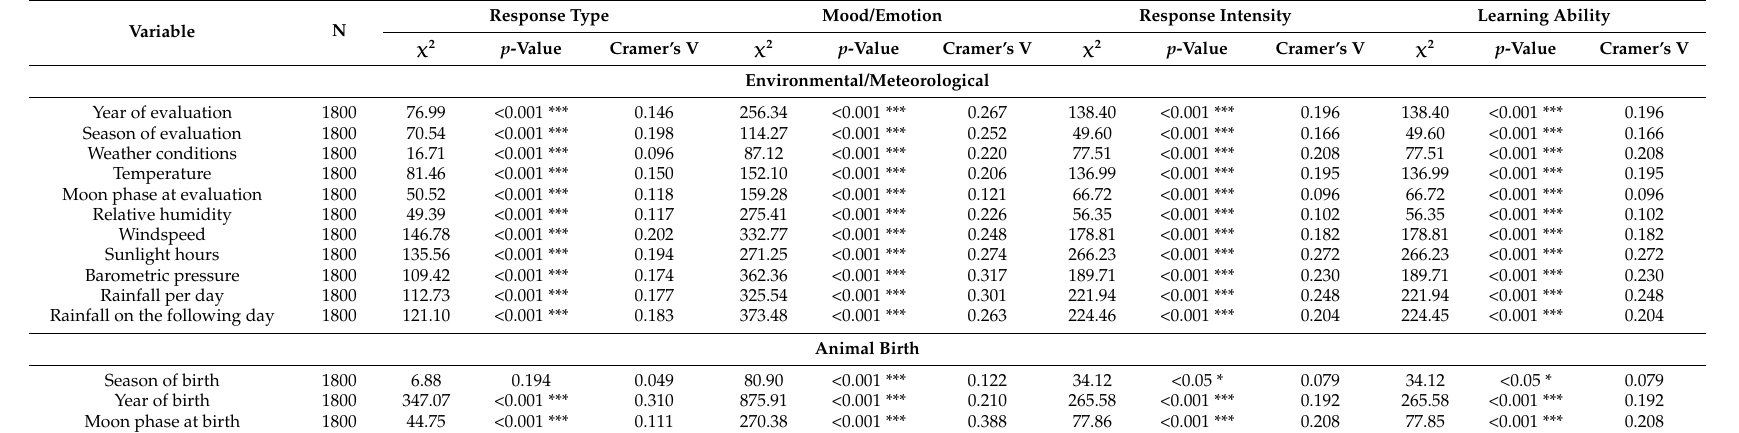
Table 3. Statistical significance and strength of the effects on the different variables tested in donkeys in this study.